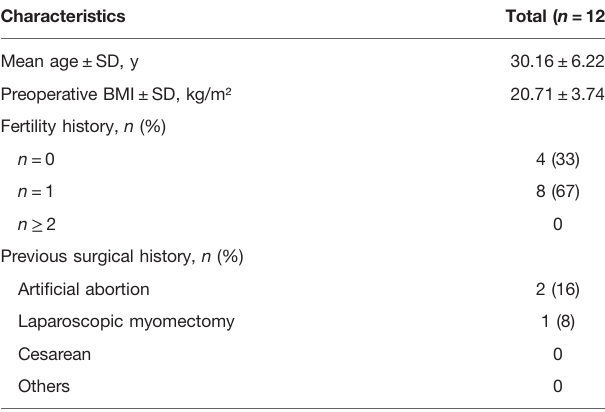
TABLE 1 | Characteristics of 12 patients who delivered after vNOTES.